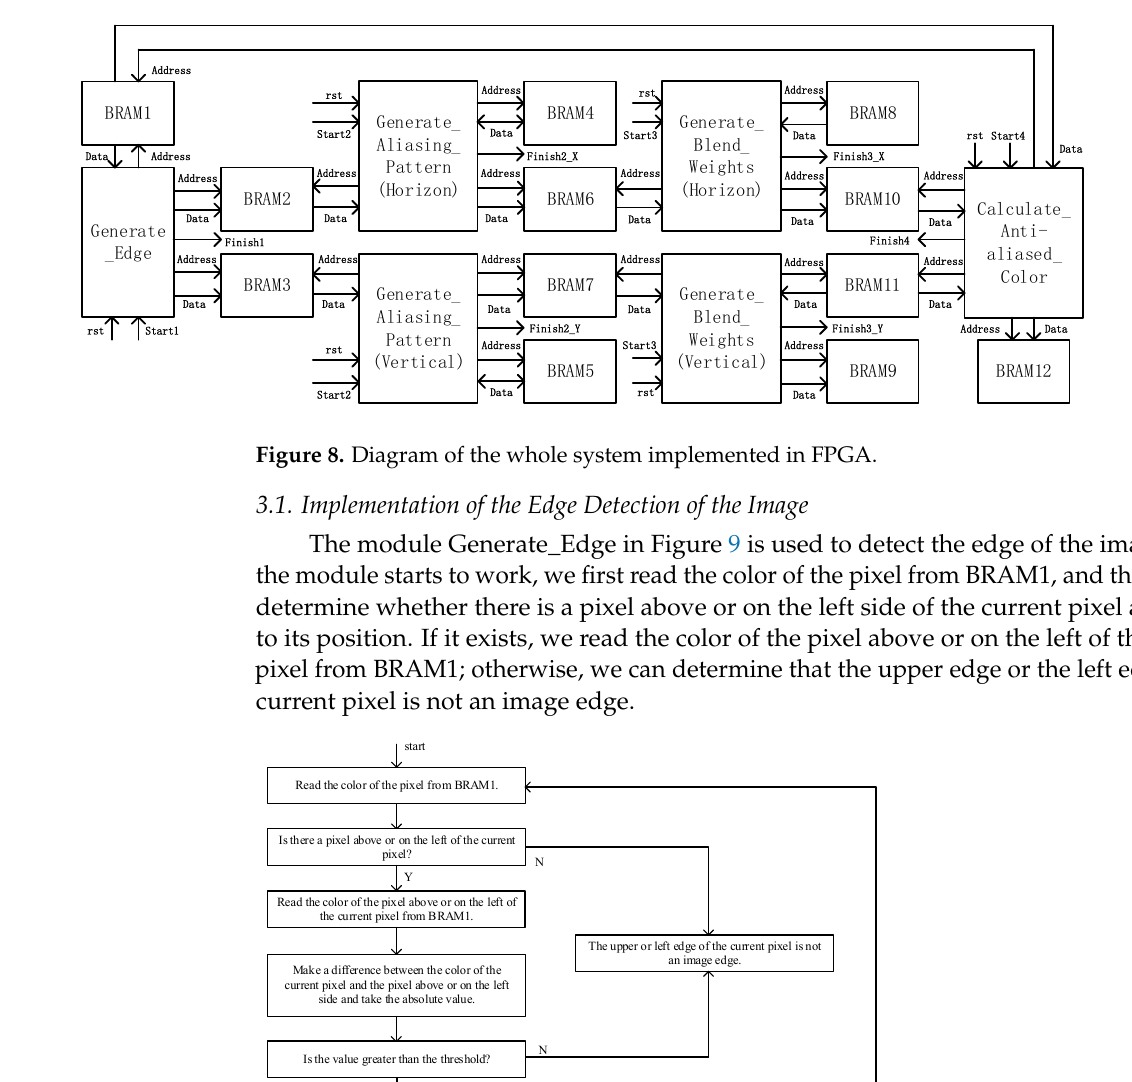
Figure 8. Diagram of the whole system implemented in FPGA.